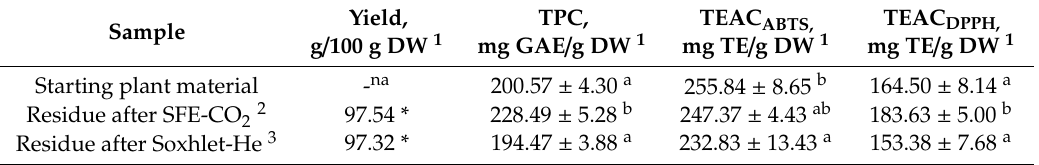
Table 1. Yields (g / 100 g), total phenolic content (TPC, mg GAE / g), ABTS • + , and DPPH •